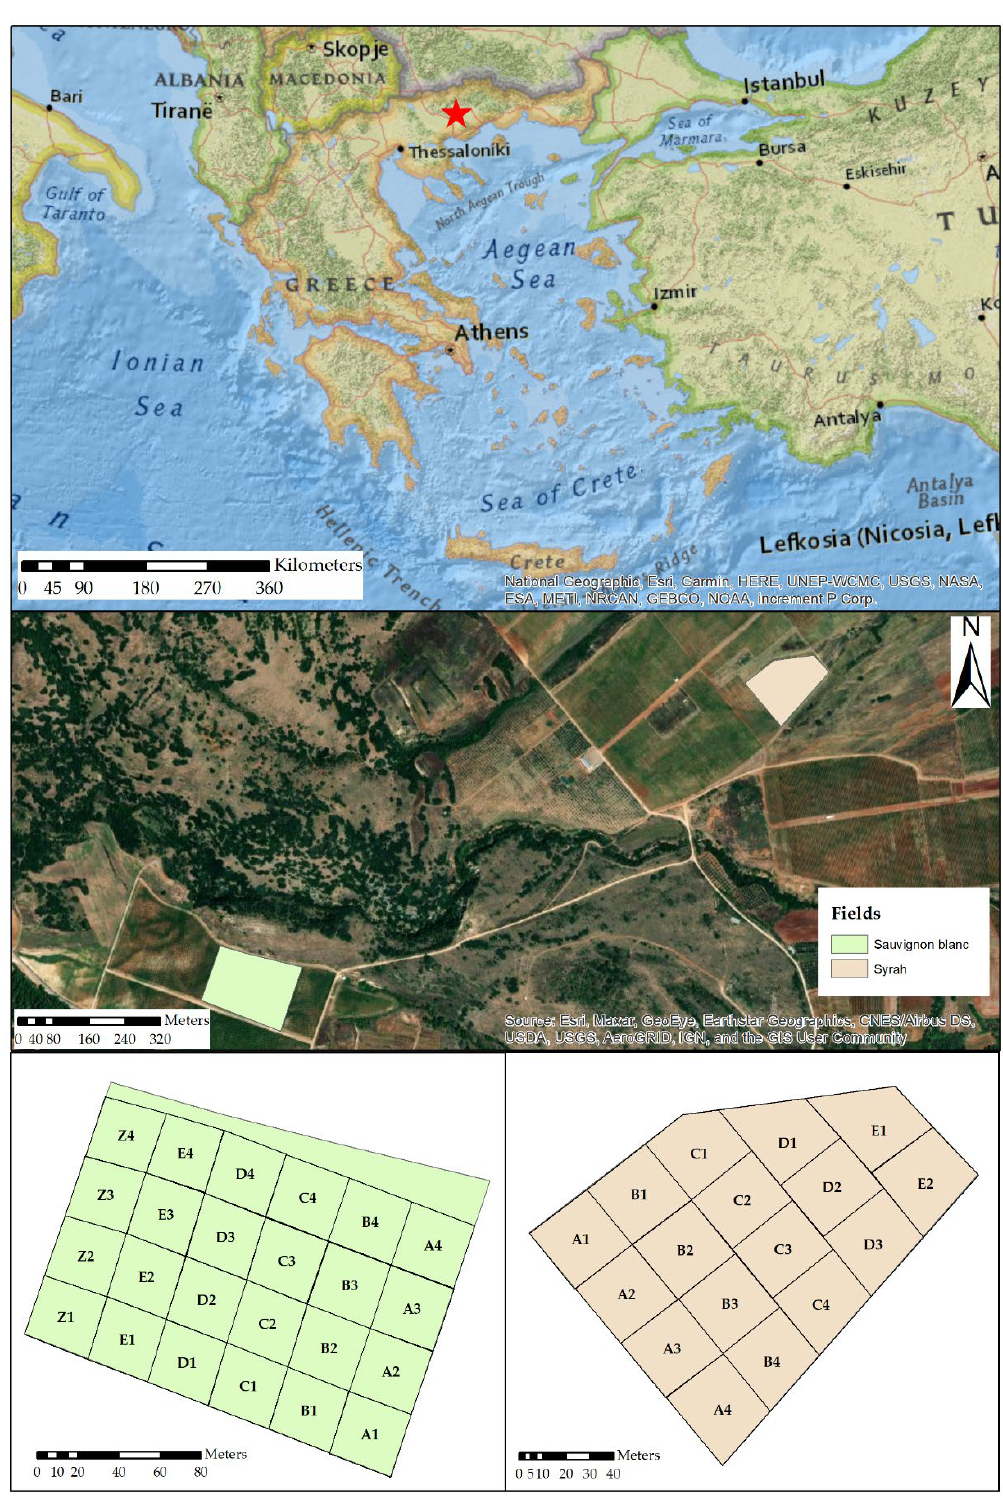
Figure 1. The location of the experimental fields.